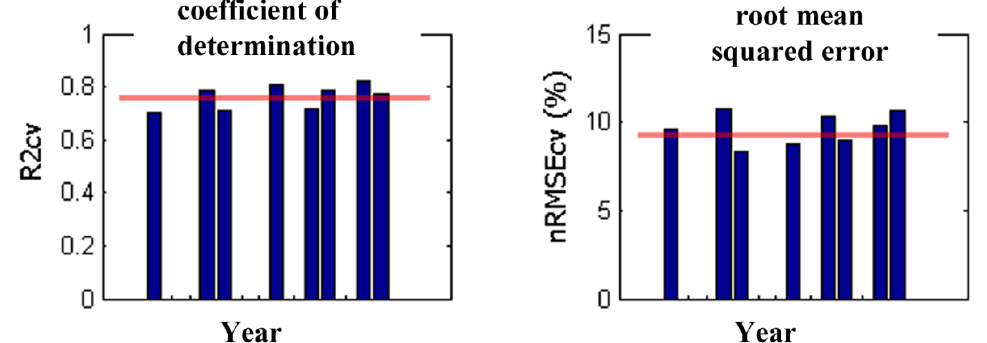
Figure 7. Cross-validated results—Tuscany’s total winter crop area—regarding the spatialization of winter crop acreages (AFIw) based on the proposed neural network approach: ( Left ): coefficient of determination, ( Right ): root mean squared error between predicted and Landsat TM/ETM+ -derived reference information. Each bar corresponds to one year of the eight-year dataset. The horizontal red line corresponds to the median of the eight